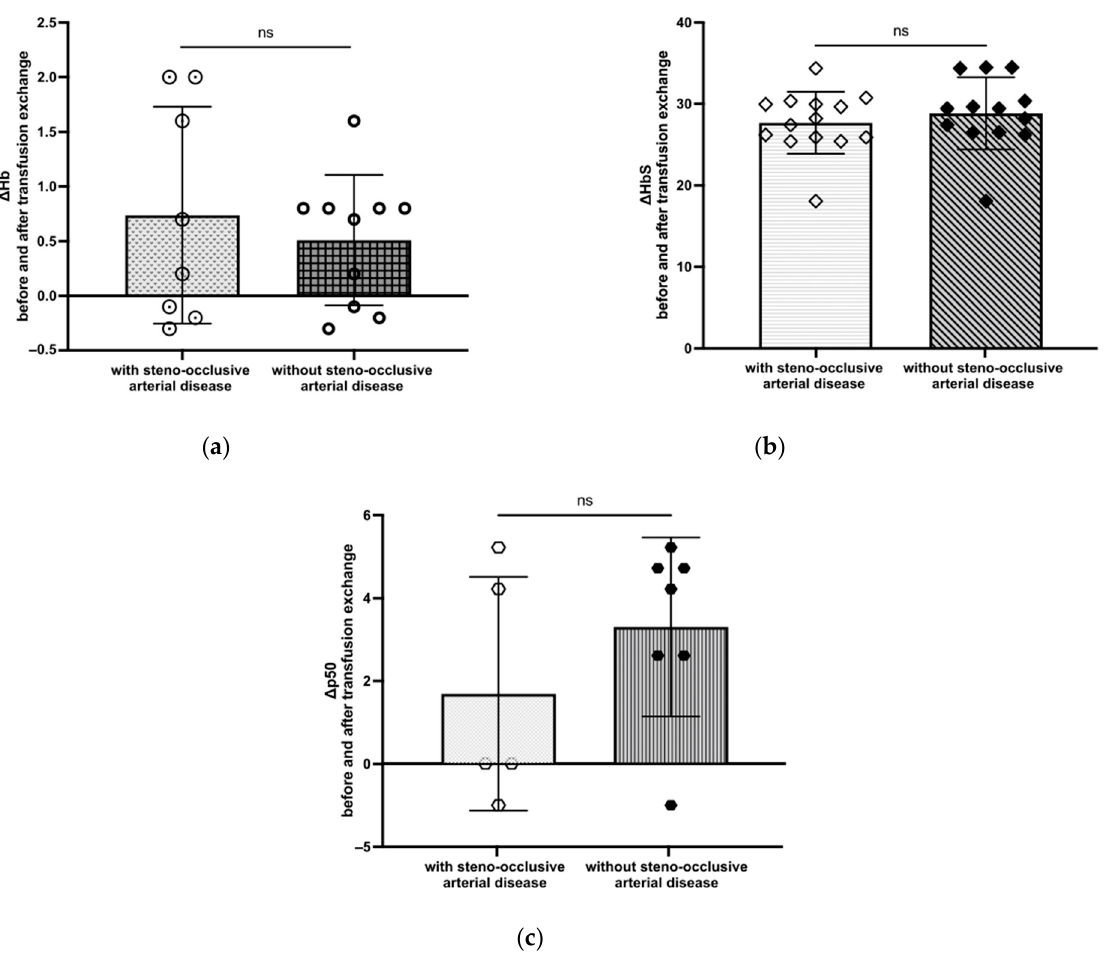
Figure A1. Measurement of Δ Hb, Δ HbS, and Δ p50 before and after BET in cerebral hemispheres with steno-occlusive arterial disease and without steno-occlusive arterial disease. Shaded boxes show values obtained. ( a ) Δ Hb in cerebral hemispheres with steno-occlusive arterial disease ( n = 8) and in cerebral hemispheres without steno-occlusive arterial disease ( n = 10). ns using the Mann– Whitney test. ( b ) Δ HbS in cerebral hemispheres with steno-occlusive arterial disease ( n = 14) and in cerebral hemispheres without steno-occlusive arterial disease ( n = 13). ns using the Mann–Whitney test. ( c ) Δ p50 in cerebral hemispheres with steno-occlusive arterial disease ( n = 5) and in cerebral hemispheres without steno-occlusive arterial disease ( n = 7). ns using the Mann–Whitney test.